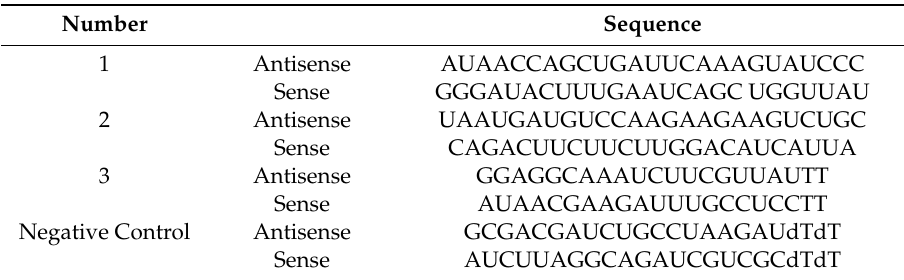
Table 2. List of ABCG2 -siRNAs used in this